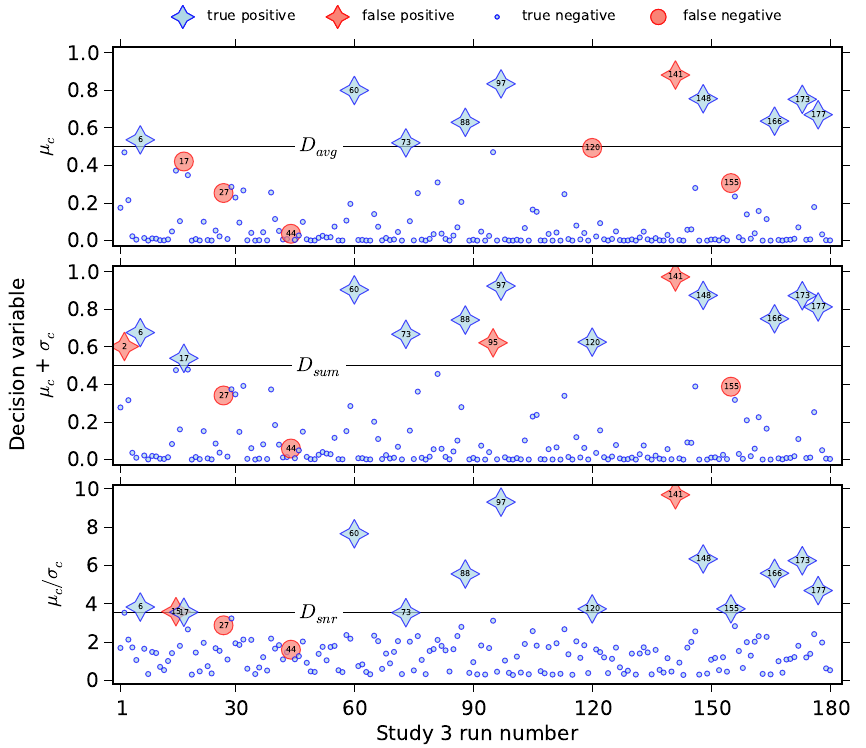
Fig. 8. Actual and predicted outcomes are shown for the 180 simulations in study 3. Predictions are based on three decision variables and thresholds ( µ c and D avg , top; µ c + σ c and D sum , middle; µ c /σ c and D snr , bottom). The horizontal axis displays simulation numbers based on their order in the ensemble. Simulation failures and successes are shown using stars and circles, respectively. Correct and incorrect predictions are shown in blue and red, respectively.